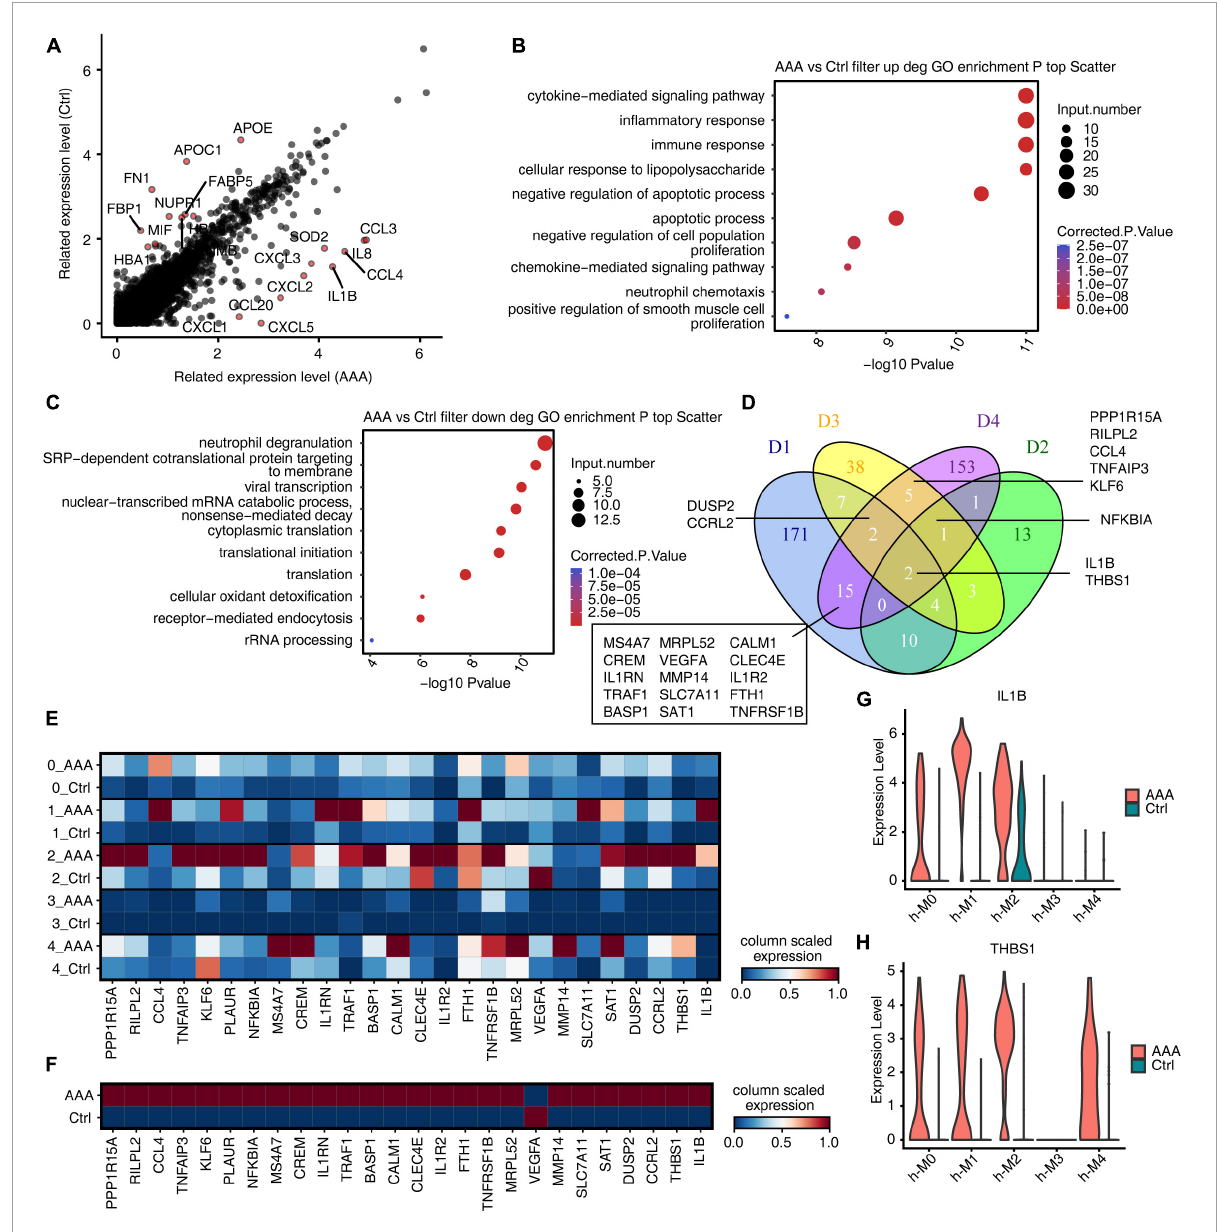
FIGURE5 IL-1 B and THBS1 were most conserved regulated genes in macrophages/monocytes (M ϕ /Mo) during abdominal aortic aneurysm (AAA) development. (A) Scatter plot displayed the differentially expressed genes in M ϕ /Mo. Red colors indicated that the top 10 upregulated or downregulated genes. (B) Gene ontology terms of upregulated genes in AAA versus in control M ϕ /Mo from human AAA dataset. The top 10 terms from upregulated genes were depicted as scatter plots displaying –log 10 ( p -value) and gene number. (C) Gene ontology terms of downregulated genes in AAA versus in control M ϕ /Mo from human AAA dataset. The top 10 terms from upregulated genes were depicted as scatter plots displaying –log 10 ( p -value) and gene number. (D) Venn diagram showing the co-upregulated genes comparing AAA M ϕ /Mo with control group from four datasets (D1–D3: mouse; D4: human). (E) Unsupervised clustering heatmap showing relative expression (column scaled) levels of upregulated genes at least in two datasets (include D4) split by human AAA and control group. (F) Same as panel (E) except that expression was showed in different subgroups of human AAA and control group. (G, H) Gene expression level of IL-1 B and THBS1 were represented in the violin plot split by human AAA and control group.